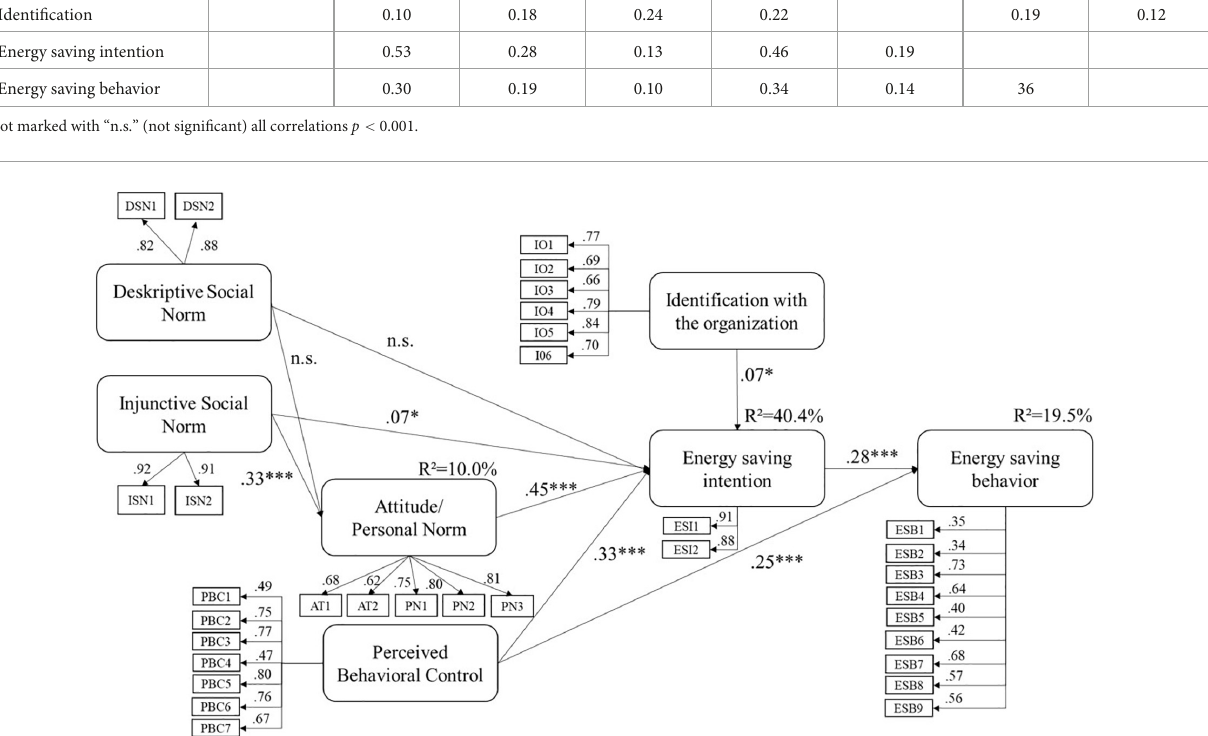
results of several other studies (e.g., Bamberg et al., 2007; White et al.,